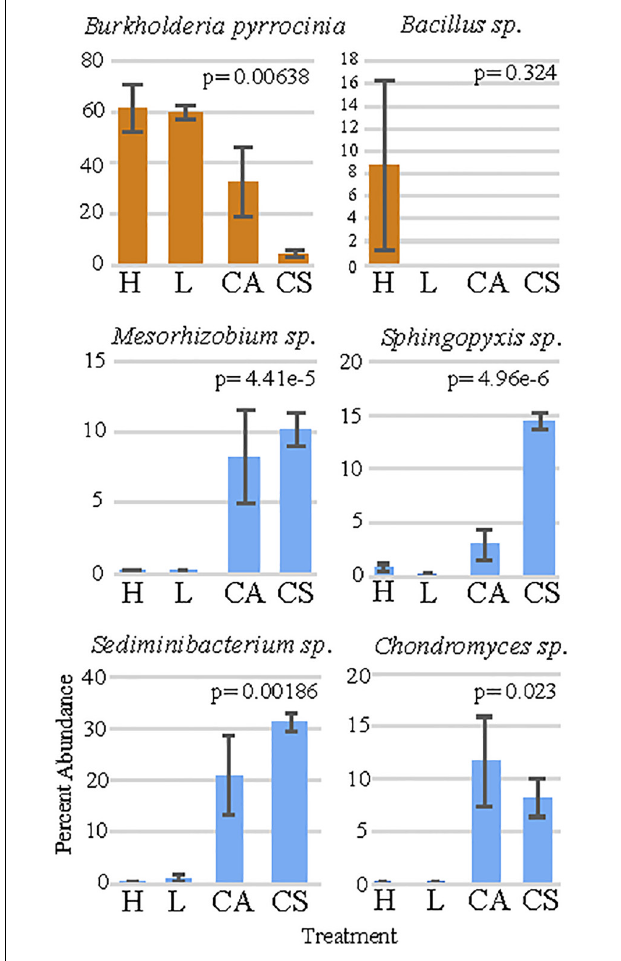
FIGURE 3 | The percent abundance of the six bacteria that are responsible for the largest dissimilarity between treatments. “H” = high permethrin concentration treatment, “L” = low permethrin concentration treatment, “CA” = acetone control, and “CS” = seawater control. Error bars represent standard